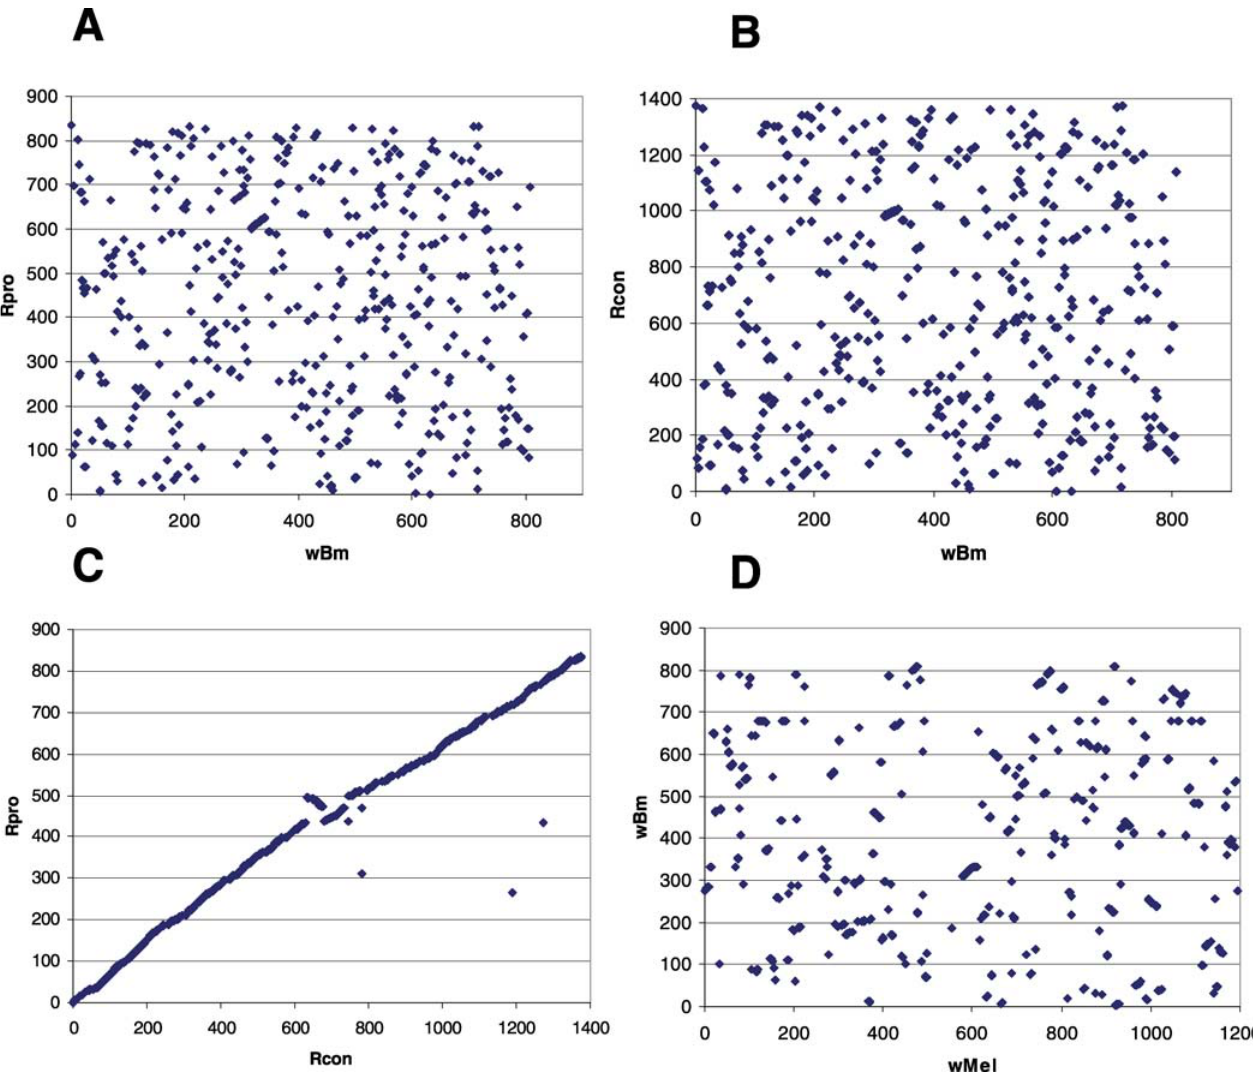
Figure 5. Absence of Gene Order Colinearity between w Bm and Rickettsia and Disruption of Gene Colinearity between w Bm and w Mel Each dot represents a pair of probable orthologs defined as reciprocal BLAST best hits with E-value less than 0.001. (A) Genome dot-plot comparison of w Bm (Wolbachia from B. malayi) and Rpro (R. prowazekii). (B) Genome dot-plot comparison of w Bm (Wolbachia from B. malayi) and Rcon (R. conorii). (C) Genome dot-plot comparison of Rpro (R. prowazekii) and Rcon (R. conorii). (D) Genome dot-plot comparison of w Bm and w Mel. DOI: 10.1371/journal.pbio.0030121.g005